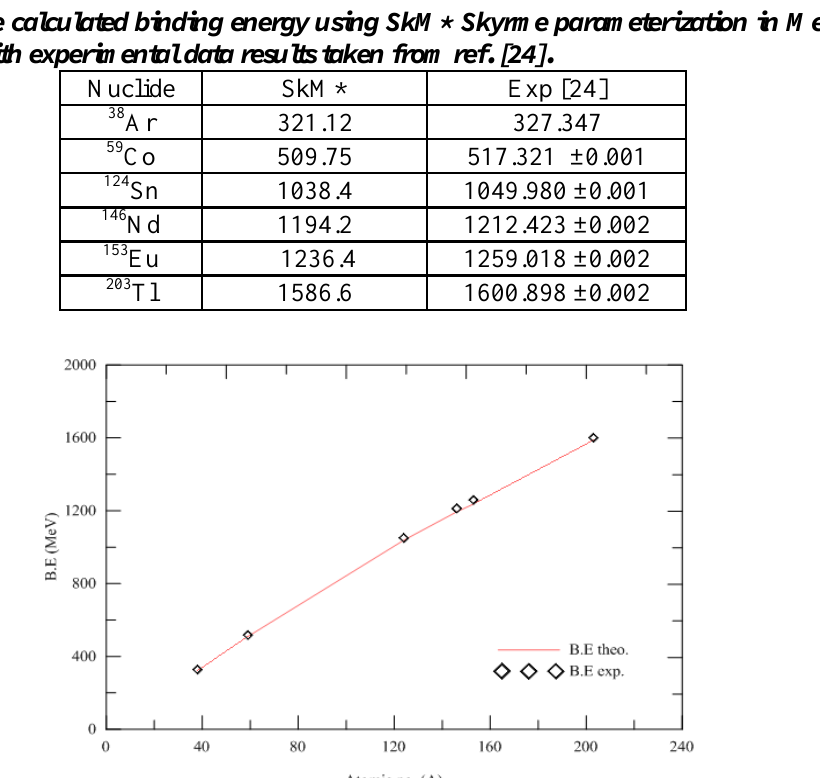
Fig.4: The calculated total binding energies for selected target nuclei calculated using the SHF